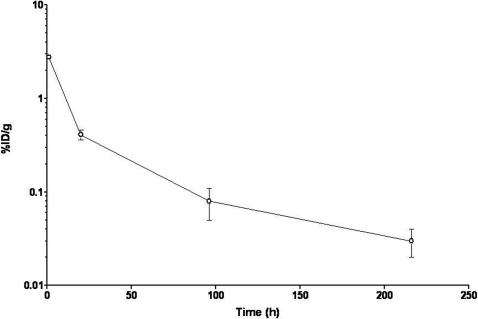
Plot of the blood clearance of 111In-CNT, compound 5, following i.v. injection (n = 3 per group).